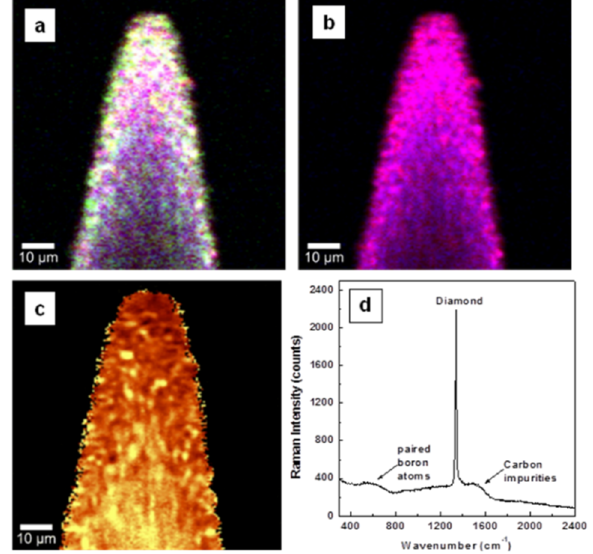
Figure 1. Surface confocal Raman images of undoped diamond film mapping the spatial distribution of: ( a ) diamond and sp 2 carbon, ( b ) diamond only, and ( c ) induced stress. Red pseudo-color is used for diamond and green for sp 2 carbon impurities. While in image ( a ) yellow originates from a combination of red and green, in the stress image ( c ), bright yellow and brown correspond to higher or lower induced stress, respectively. ( d ) integrated Raman spectrum of image ( a ).